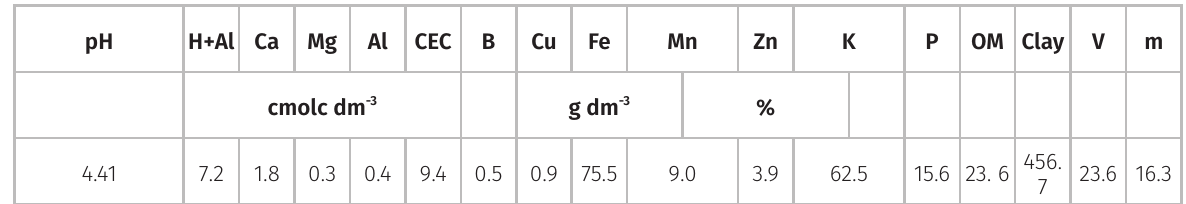
pH CaCl2; H + Al: Potential acidity; Ca: Calcium; Mg: Magnesium; Al: Aluminum; CEC: Cation exchange capacity; B: Boron; Cu: Copper; Fe: Iron; Mn: Manganese; Zn: Zinc; K: Potassium; P: Phosphorus (resin); OM: Organic matter; Clay: Clay content; V: base saturation; m: Aluminum